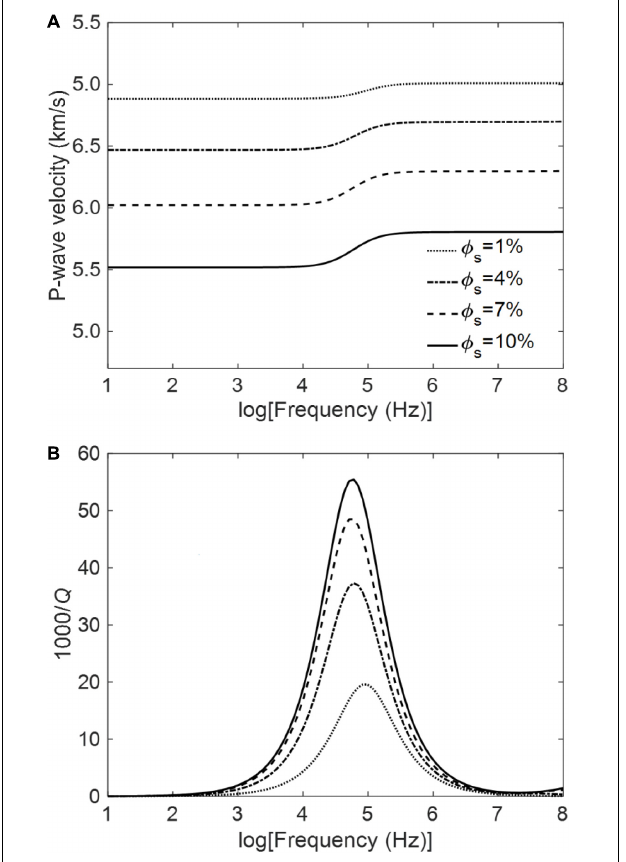
FIGURE 3 | P-wave velocity (A) and attenuation (B) as a function of frequency for varying stiff